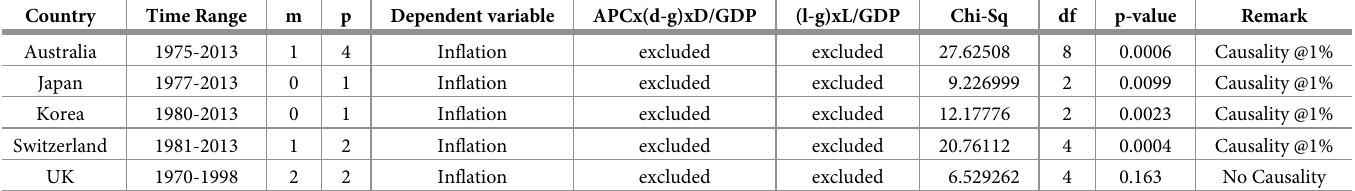
Table 18. VAR Granger Causality/Block Exogeneity Wald Test (proposed model).